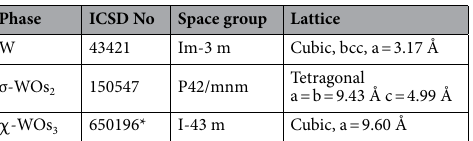
Table 1. Summary of crystal structures used for JEMS modelling. *ICSD number belongs to the WRe 3